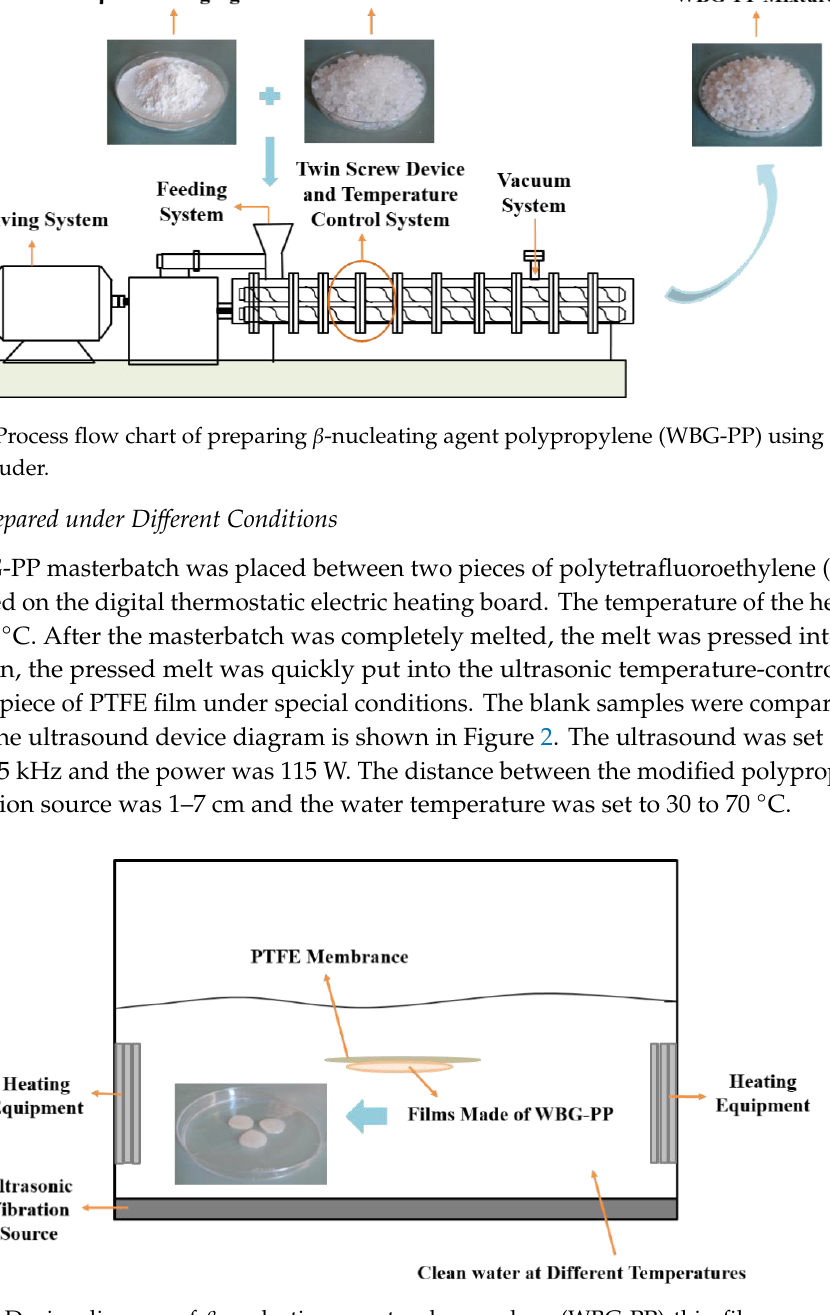
Figure 1. Process flow chart of preparing β -nucleating agent polypropylene (WBG-PP) using a twin-screw extruder.